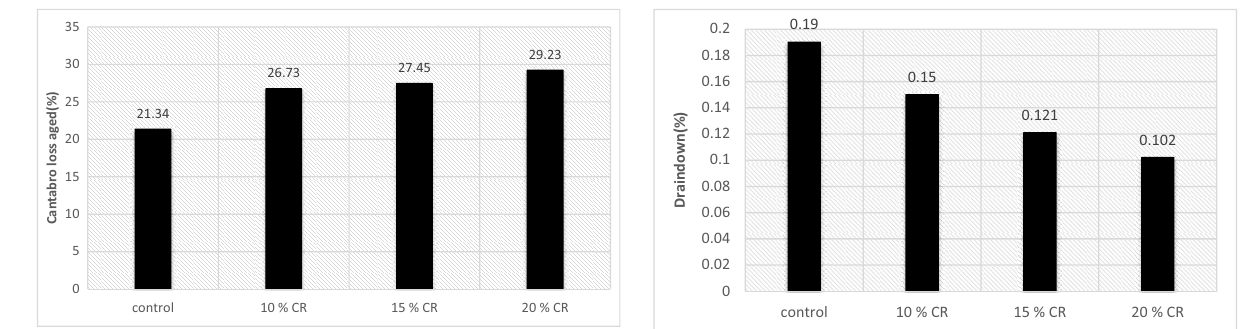
Figure 6: The results of the Cantabro aged test.